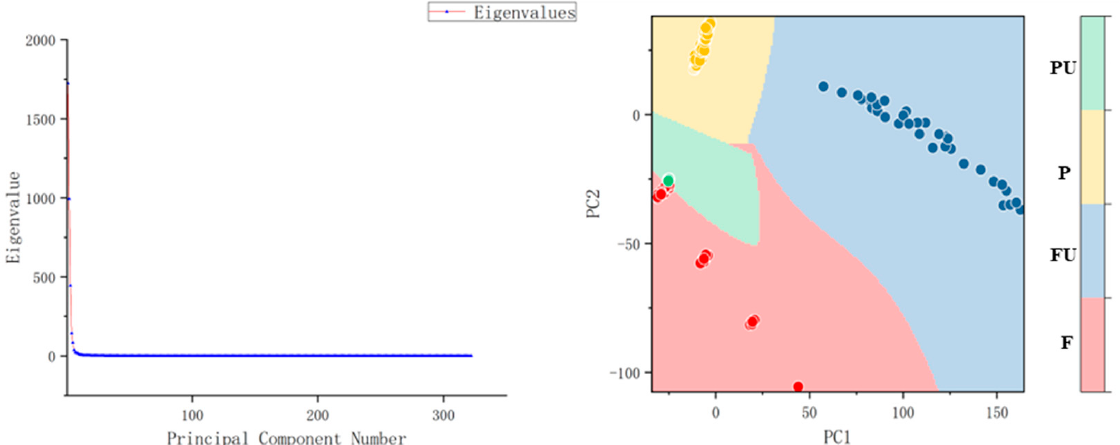
Figure 10. In the PCA experiment, the cumulative of the first three PCs is 87.77%, and the cumulative of the first four PCs is 91.73%. The classification accuracy of SVM is 99.69. The reason for the error is that there are some similar characteristics between PC1 and PC2 of F and PU.